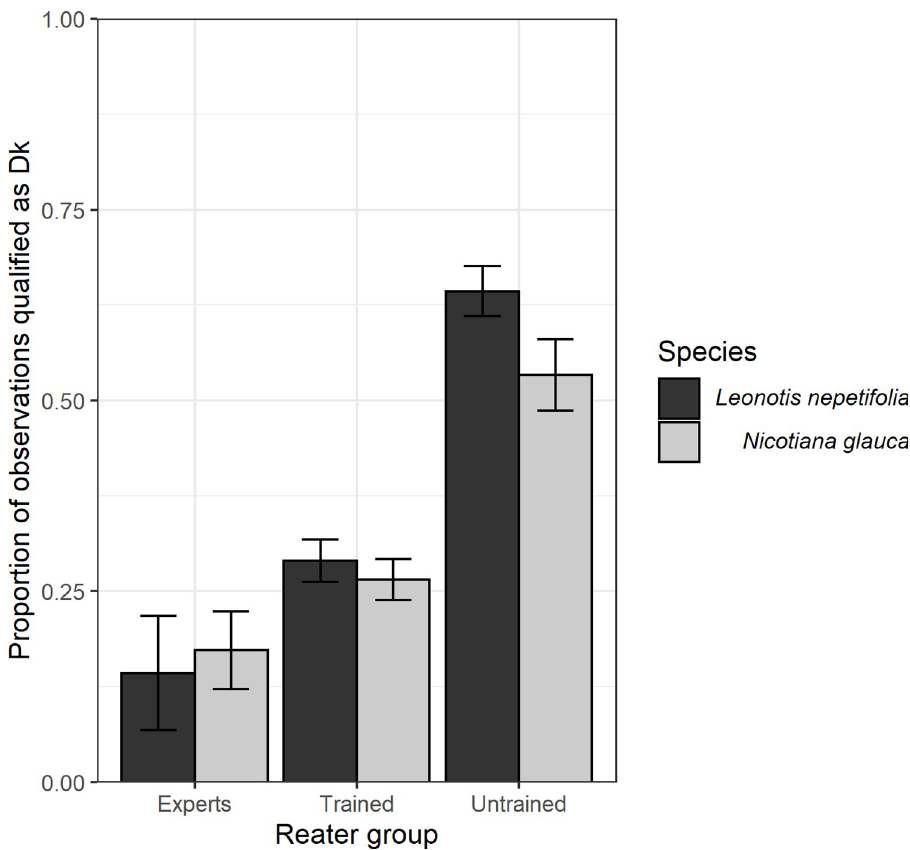
Fig 2. Two views of observations reviewed by volunteers on the Naturalista website. A record of each species used in this study, Leonotis nepetifolia (top) and Nicotiana glauca (bottom), is shown. The N . glauca observation is composed of two photographs, marked on the image with a blue box. The photograph of L . nepetifolia shows the phenophases of new growth, immature flower, mature flower, and dried fruit. The photograph of N . glauca shows the immature flower, mature flower, and dried fruit